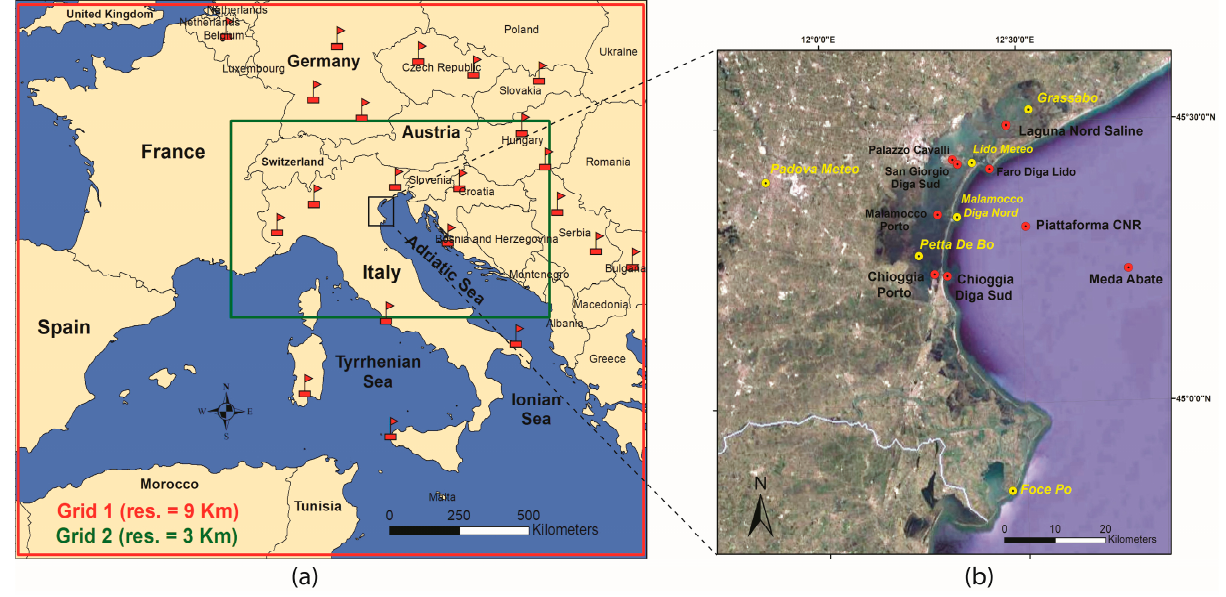
Figure 1. ( a ) Domains used in the WRF model simulations with grid spacing of 9 km (red rectangle) and 3 km (green rectangle). The red flags represent the position of the radiosondes for which the bulletinsat 12:00 UTC, 12 November 2019, are available. ( b ) Zoomed-in view of the Venice Lagoon and its surroundings, with identification of the weather surface stations managed by CPSM (red marks) and those managed by the ISPRA Institute (yellow marks).The map background is a satellite image acquired by Google Earth on 14 December 2015.